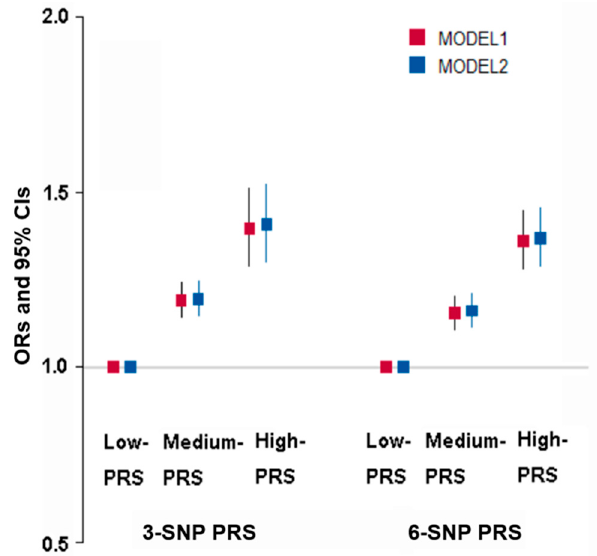
Figure 4. Adjusted odds ratio (ORs) and 95% confidence intervals (CI) of three-SNP PRS and six-SNP PRS for obesity defined with body fat mass. PRS was generated with the sum of the number of risk alleles in each SNP, and it was classified as low PRS, medium PRS, and high PRS according to the PRS was 0–2, 3–4, and ≥ 5 in the three-SNP model and 0–5, 6–7, and ≥ 8 in the six-SNP model, respectively. Models 1 and 2 were conducted with different covariates. Covariates were age, gender, residence area, education, and income for models 1 and 2 plus energy intake, alcohol intake, regular exercise, and smoking status.